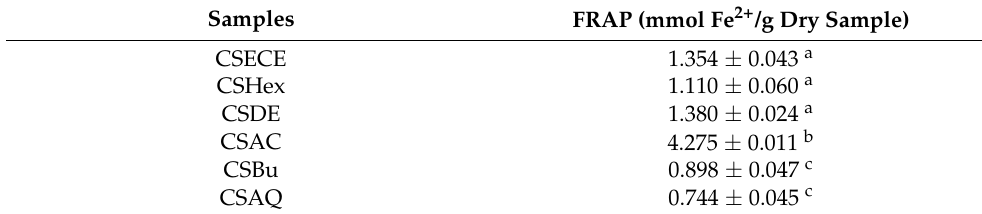
Table 5. Results of the FRAP test of different